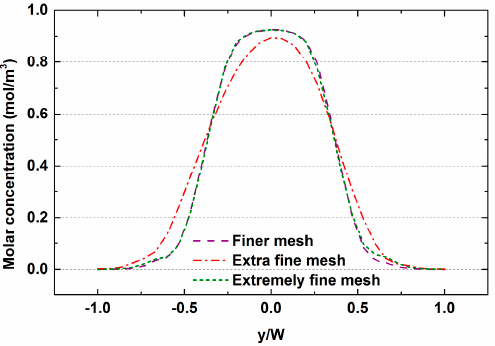
Figure 23. Grid independence verification: molar concentration distribution.